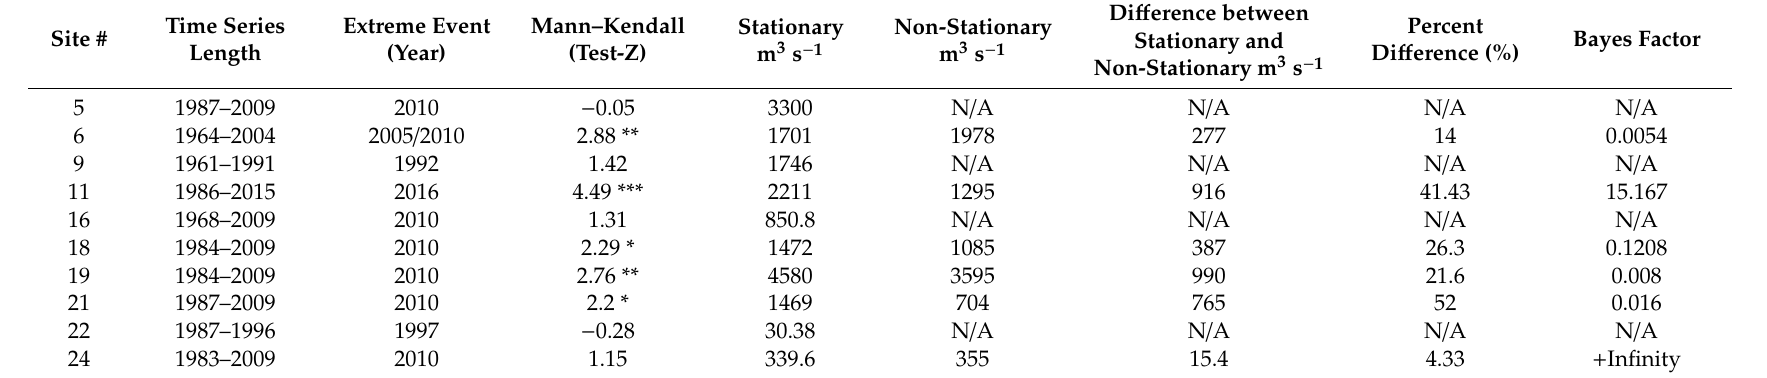
Table 7. Performance of Bayesian models for predicting the extreme floods in the KRB,